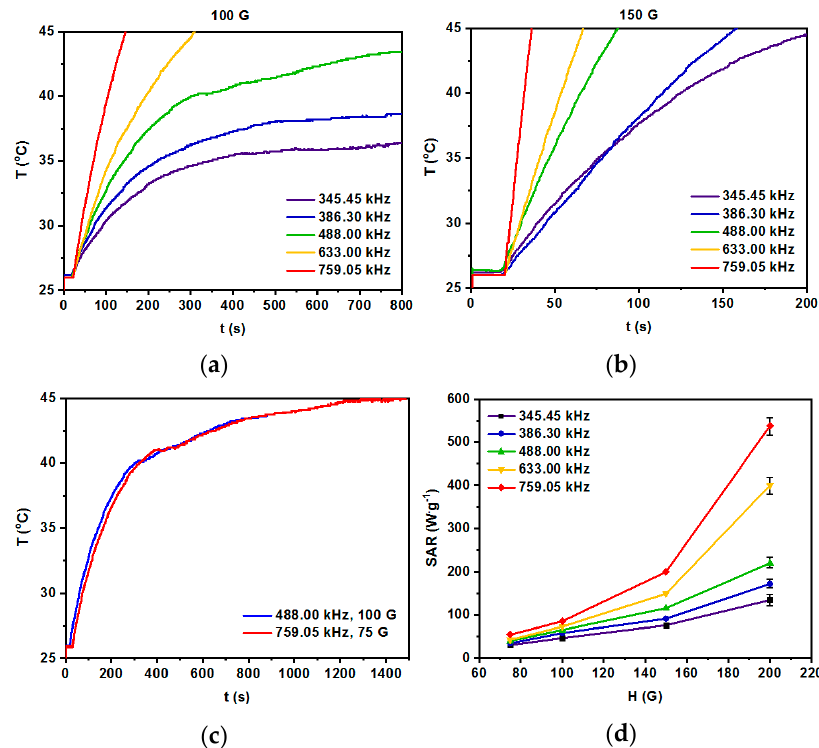
Figure 7. Heating of radio-labeled [Ho]Fe 3 O 4 @Au-Tmab bioconjugate in various ranges of frequency of magnetic field: ( a ) 100 G, ( b ) 150 G, ( c ) 75 – 150 G, and ( d ) dependence of SAR for various frequencies of the magnetic field as a function of the amplitude of the magnetic field. S.D. bar represents the largest value of five independent experiments.